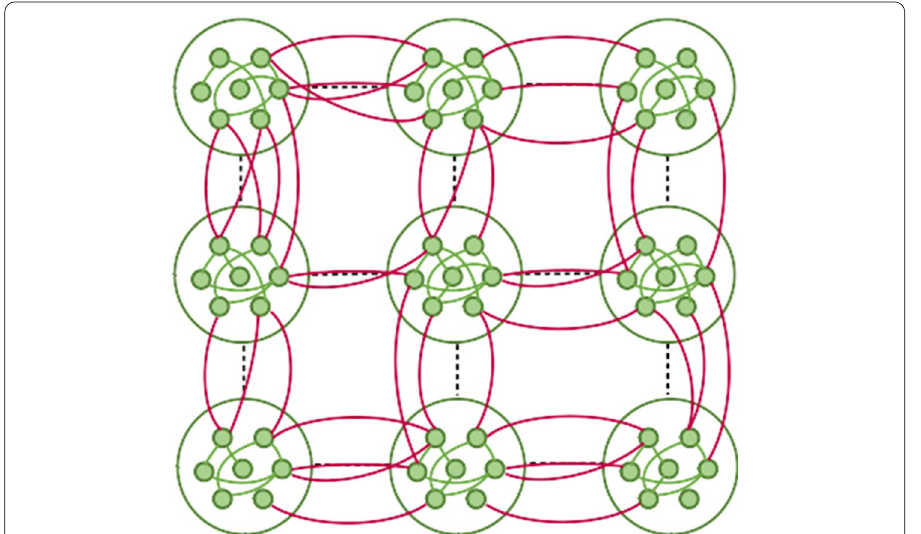
Fig. 1 Illustration of the model. The spatial modular model represents a structure of a network of infection channels inside cities (modules) and between cities. Inside a city, the infection channels are dense and spread randomly between different areas of the city (green links) like in an Erdős–Rényi network having random like structure while the infection channels from one city to another is usually possible between neighbouring cities (red links) having spatial like